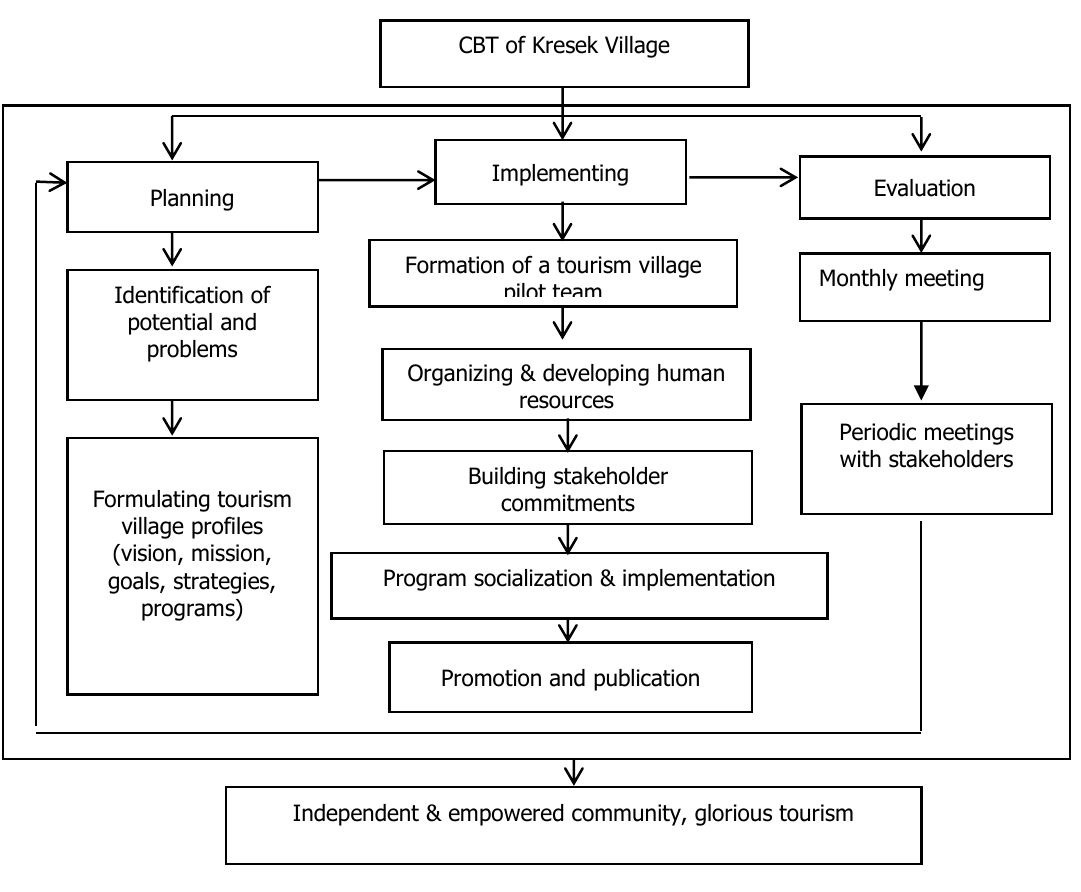
Figure 1. CBT of Kresek